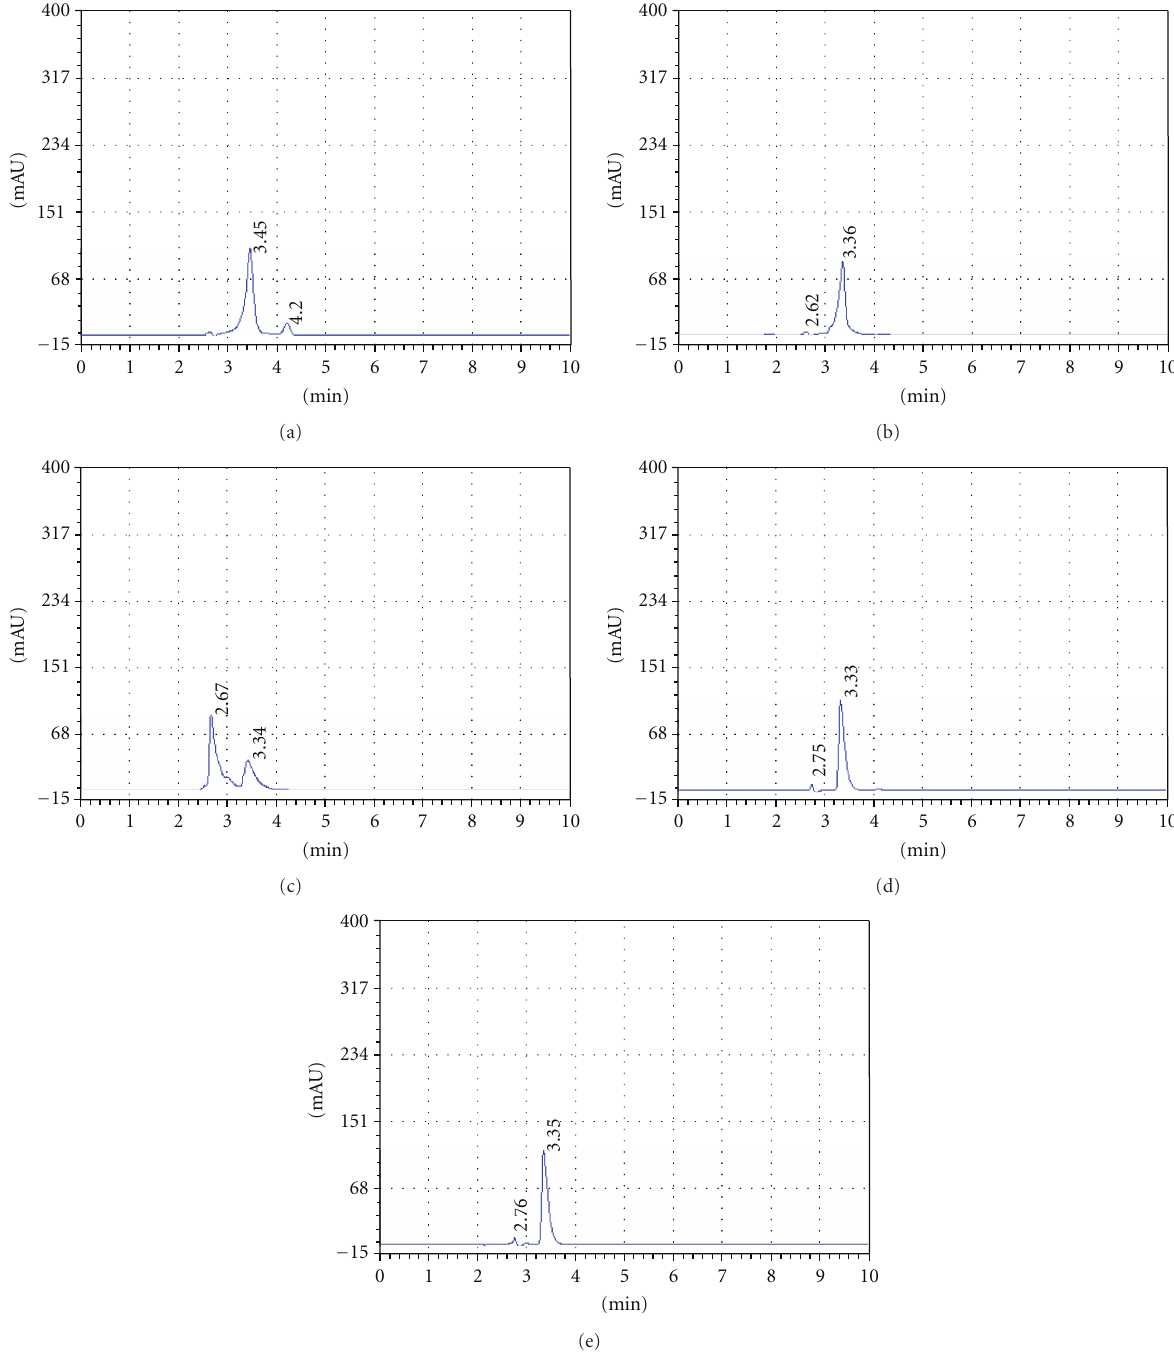
Figure 1: Typical HPLC chromatograms of: (a) acid hydrolysis-degraded active pharmaceutical ingredient (API), (b) base hydrolysis- degraded API, (c) oxidative degraded API, (d) thermal degrade API, and (e) photodegraded